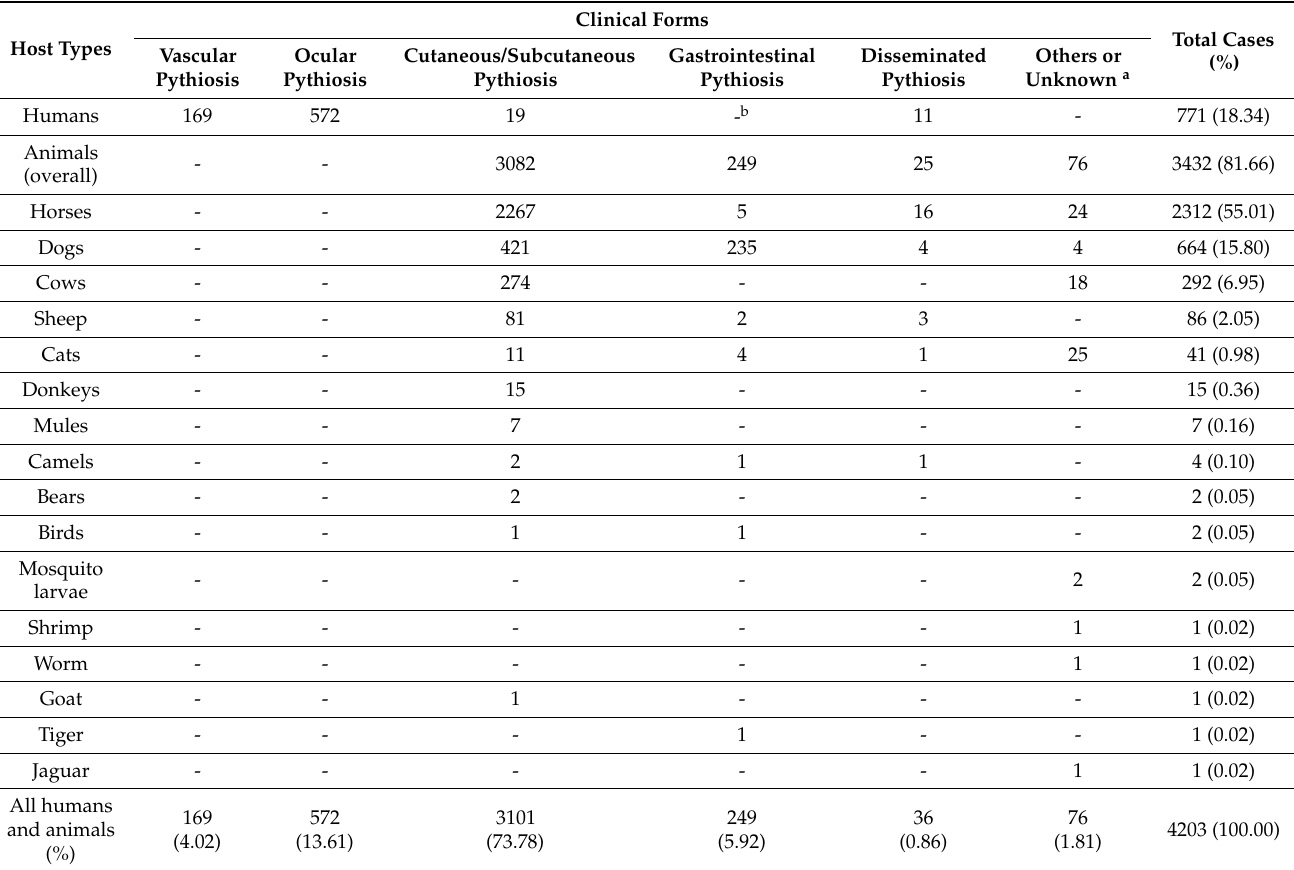
Table 3. The number of pythiosis cases based on host types and clinical